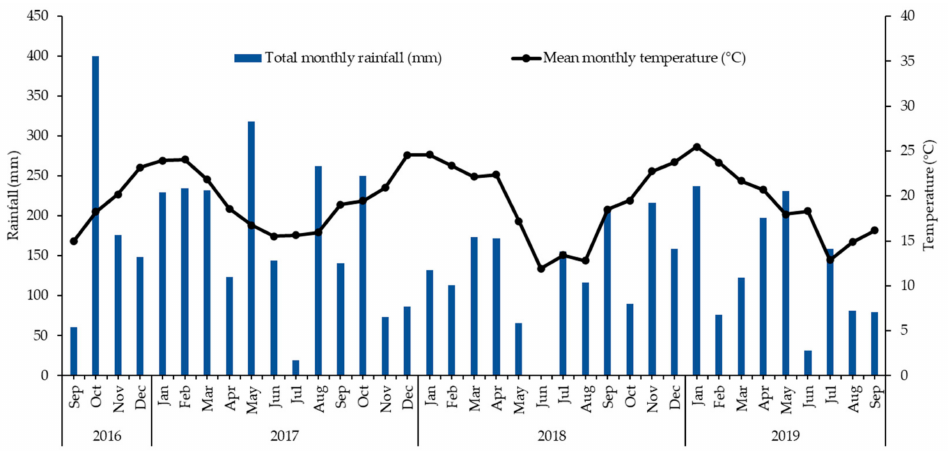
Figure 1. Total monthly rainfall (mm) and mean monthly air temperature ( ◦ C) throughout the study conducted with H. heptaphyllus plants in the field—data were provided by the weather station